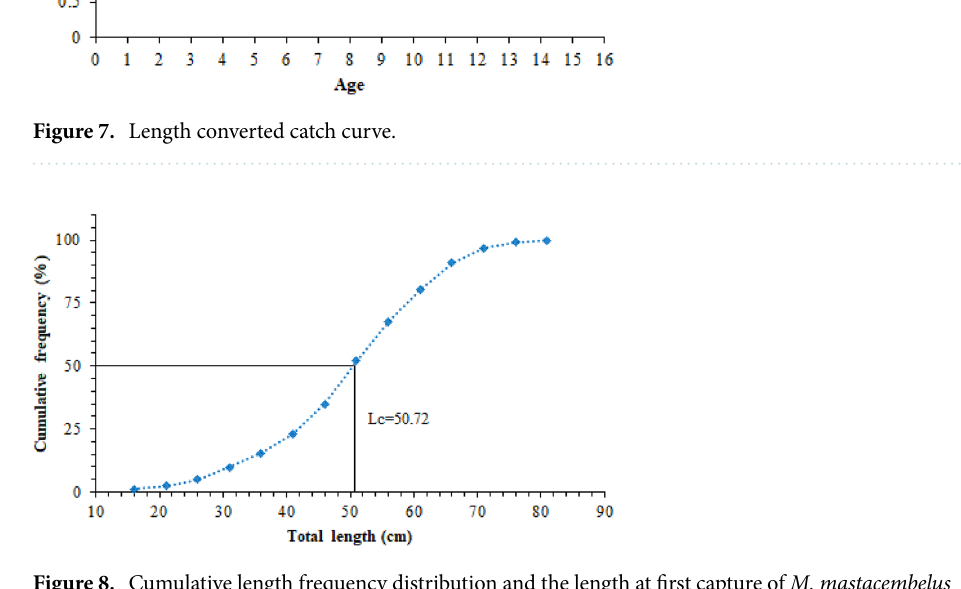
Figure 8. Cumulative length frequency distribution and the length at first capture of M. mastacembelus population inhabiting Keban Dam